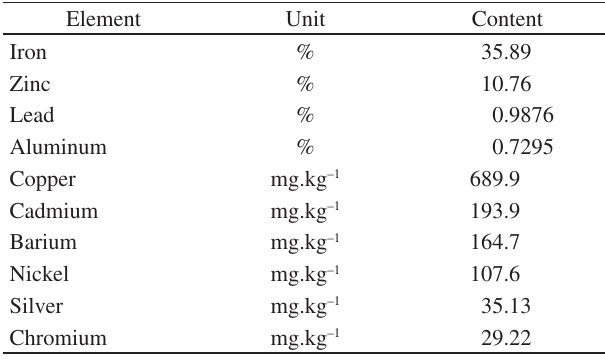
Table 2. Chemical composition of EAFD.